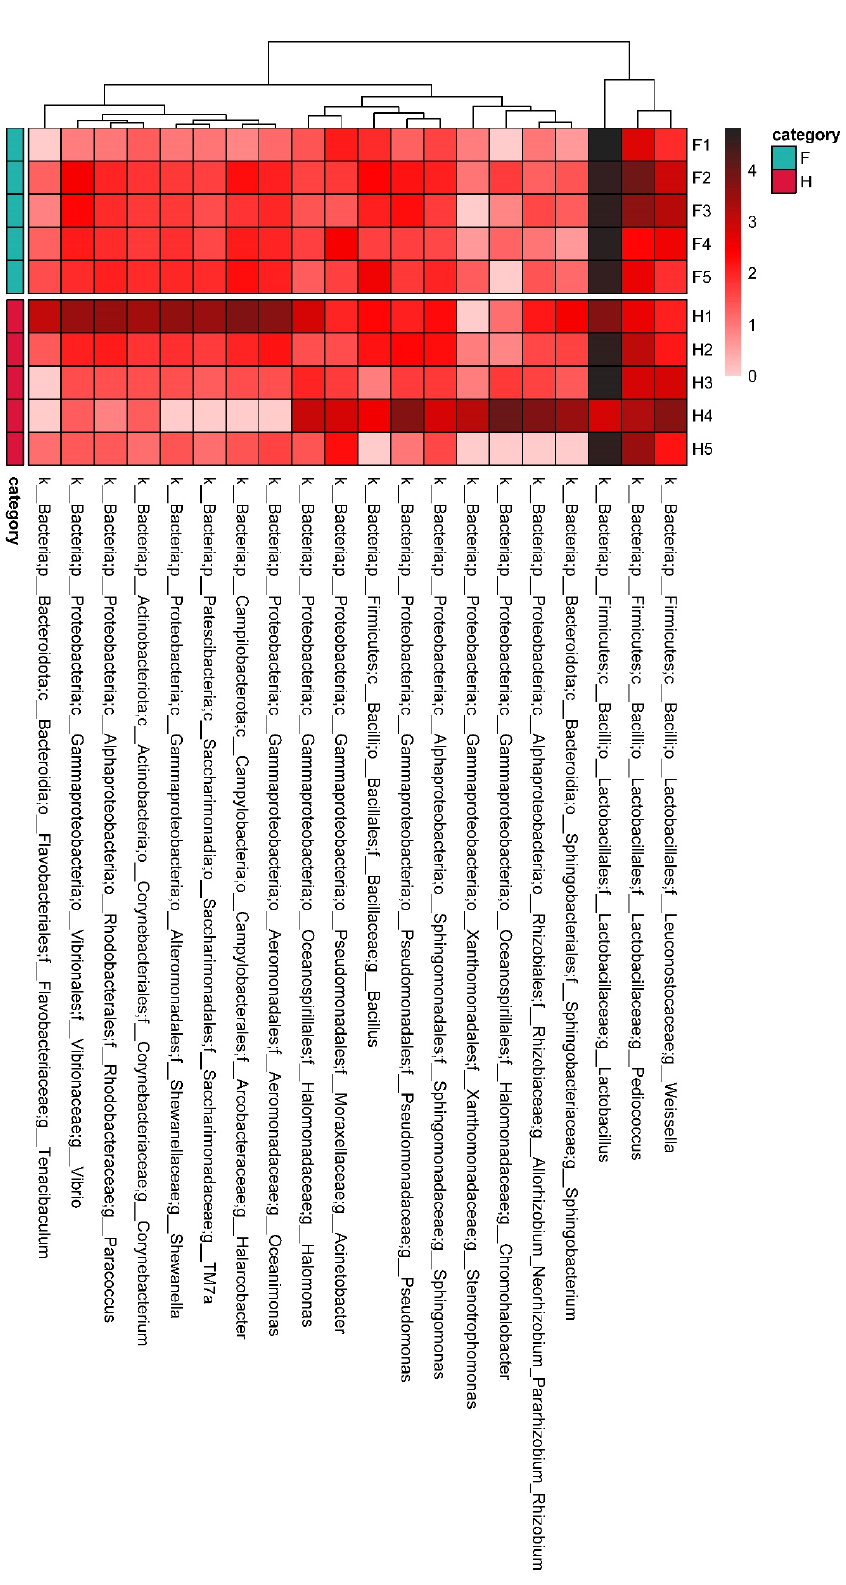
Figure 5. Genus-level relative abundance heatmap. F means factory production; H means household handmade. The vertical column is the sample name information. Annotation names for the genus level are classified horizontally. The clustering tree at the top of the figure clusters the similarity of species abundance distribution in all samples. The middle heatmap is a log10 (absolute abundance) heatmap.